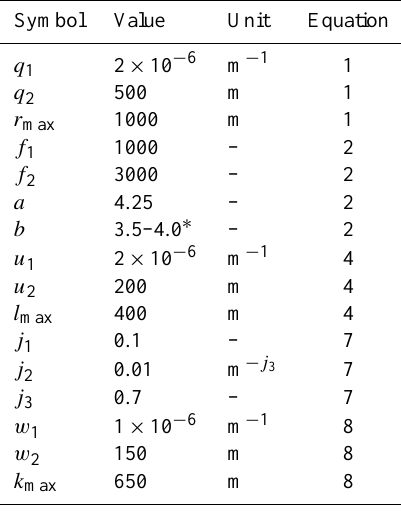
Table 1. Used parameter values and